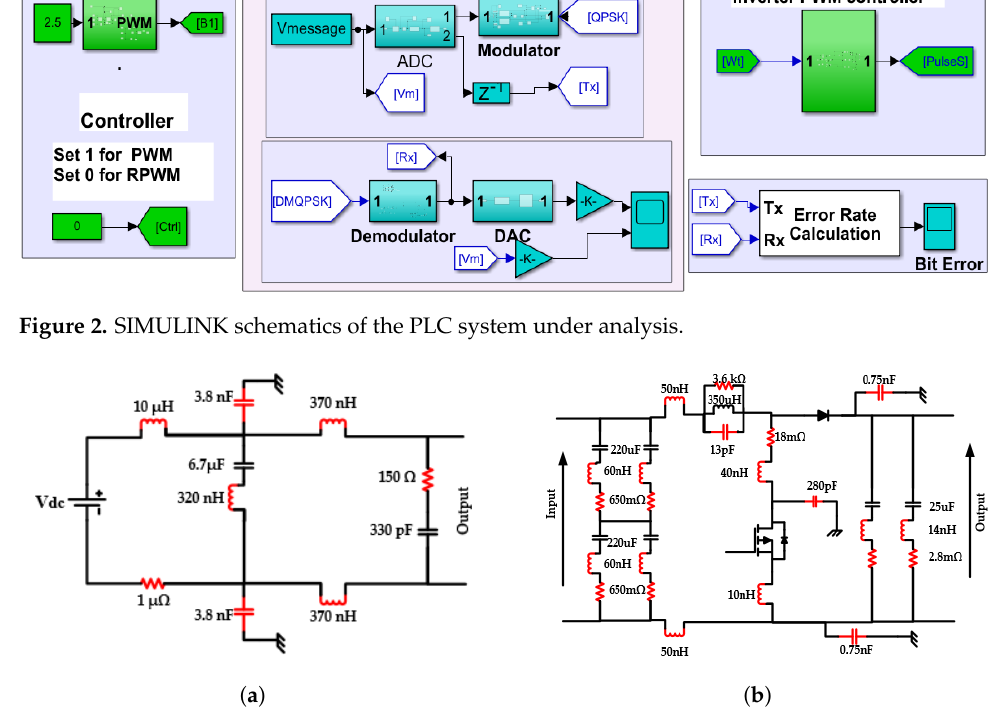
Figure 3. Implemented SIMULINK model of ( a ) battery, ( b ) DC-DC converter (parasitics elements are outlined in